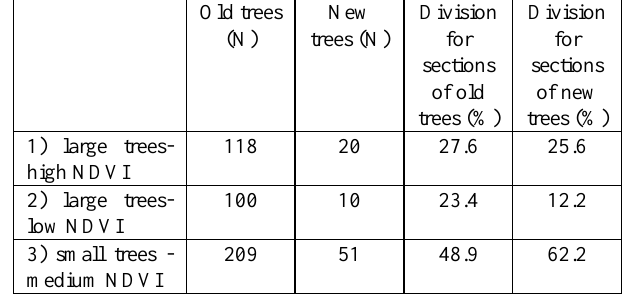
Table 3. Summary table of change detection and spatial analysis integration